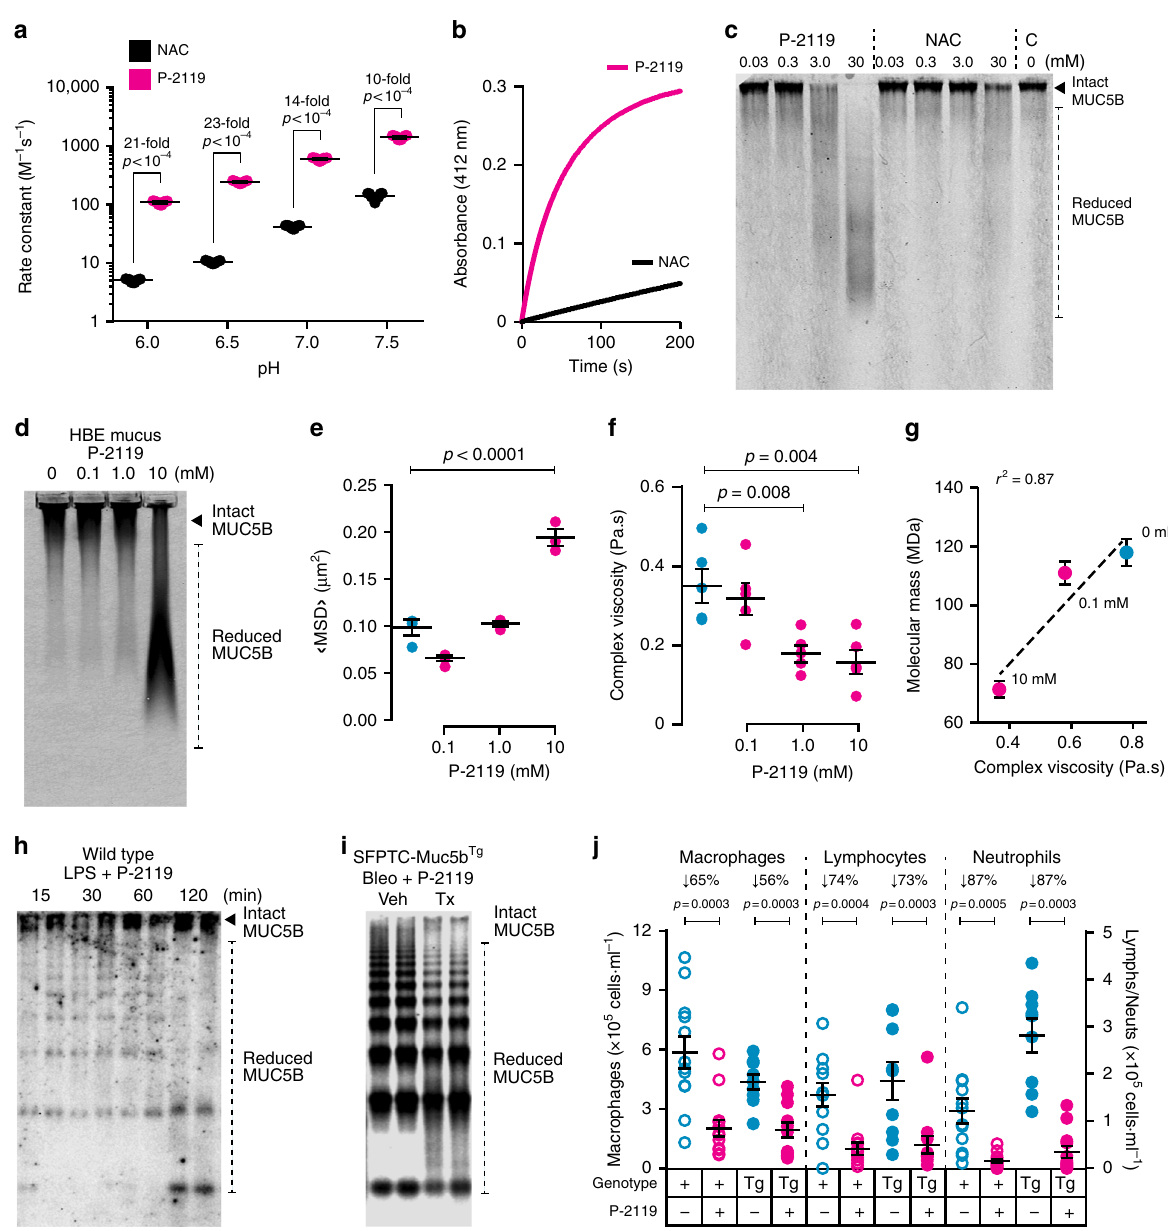
Fig. 3 P-2119 effectively cleaves mucus in vitro and in vivo, enhancing the acute clearance of in fl ammatory cells. a , b P-2119 hydrolyzed DTNB disul fi de bonds more quickly than n-acetylcysteine (NAC) a , and at pH 6 P-2119 cleaved more bonds than NAC b . c In human saliva, P-2119 reduced MUC5B in salivary mucus at lower concentrations than NAC. d – g In concentrated normal human bronchial epithelial cell culture mucus (5% solids), P-2119 reduced MUC5B at a potency similar to that seen in saliva in c . Reduction of MUC5B by P-2119 dose dependently lowered mucus viscosity as demonstrated by enhanced mean square displacement (MSD) of fl uorescent microspheres e , and as shown by improved macrorheological complex viscosity f that was strongly correlated with reduced molecular mass g . Data in e represent 900 technical and three biological replicates; data in f represent three technical and two biological replicates. Cyan symbols, vehicle; magenta symbols, P-2119. h – j In vivo effects of aerosolized P-2119 (68 – 135 mM for 60 min). h Wild-type mice challenged with LPS (20 μ g, IT) 48 h prior to P-2119 aerosol. P-2119 decreased Muc5b mass detected by immunoblot of lung lavage fl uid over a